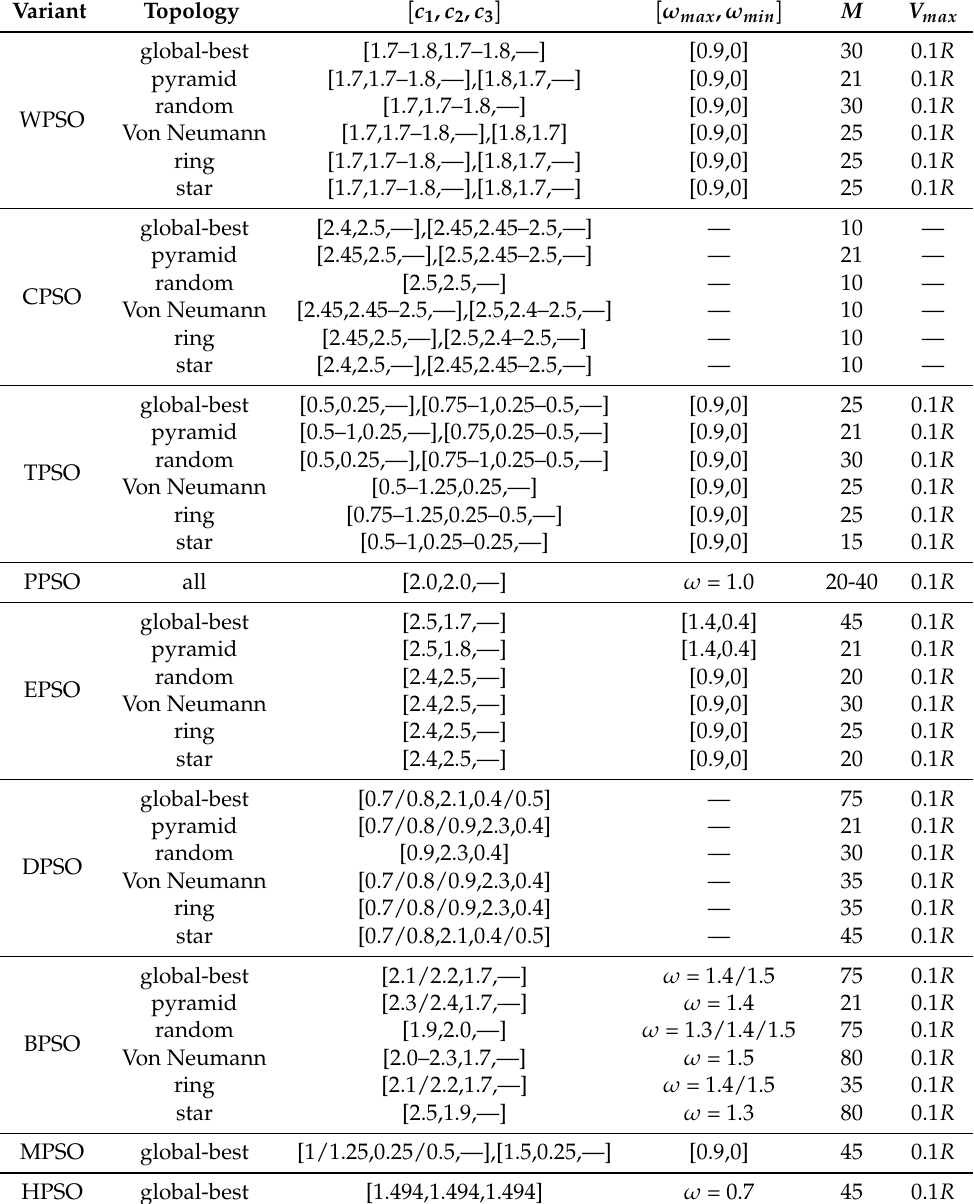
Table 3. Parameter selections of PSO-based localization algorithms. BPSO: Binary